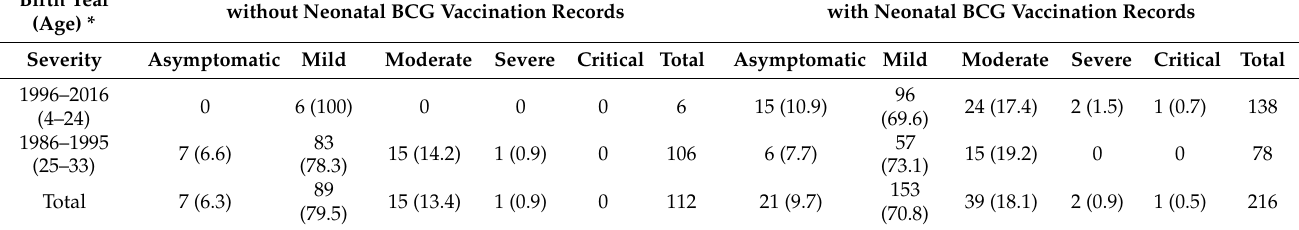
Table 1. Clinical syndromes associated with COVID-19 stratified by participant’s Tokyo-172 BCG vaccination status among age 4–24 years and 25–33 years between 21 January and 19 March 2021 in Taiwan. Birth Year without Neonatal BCG Vaccination Records with Neonatal BCG Vaccination (Age) *